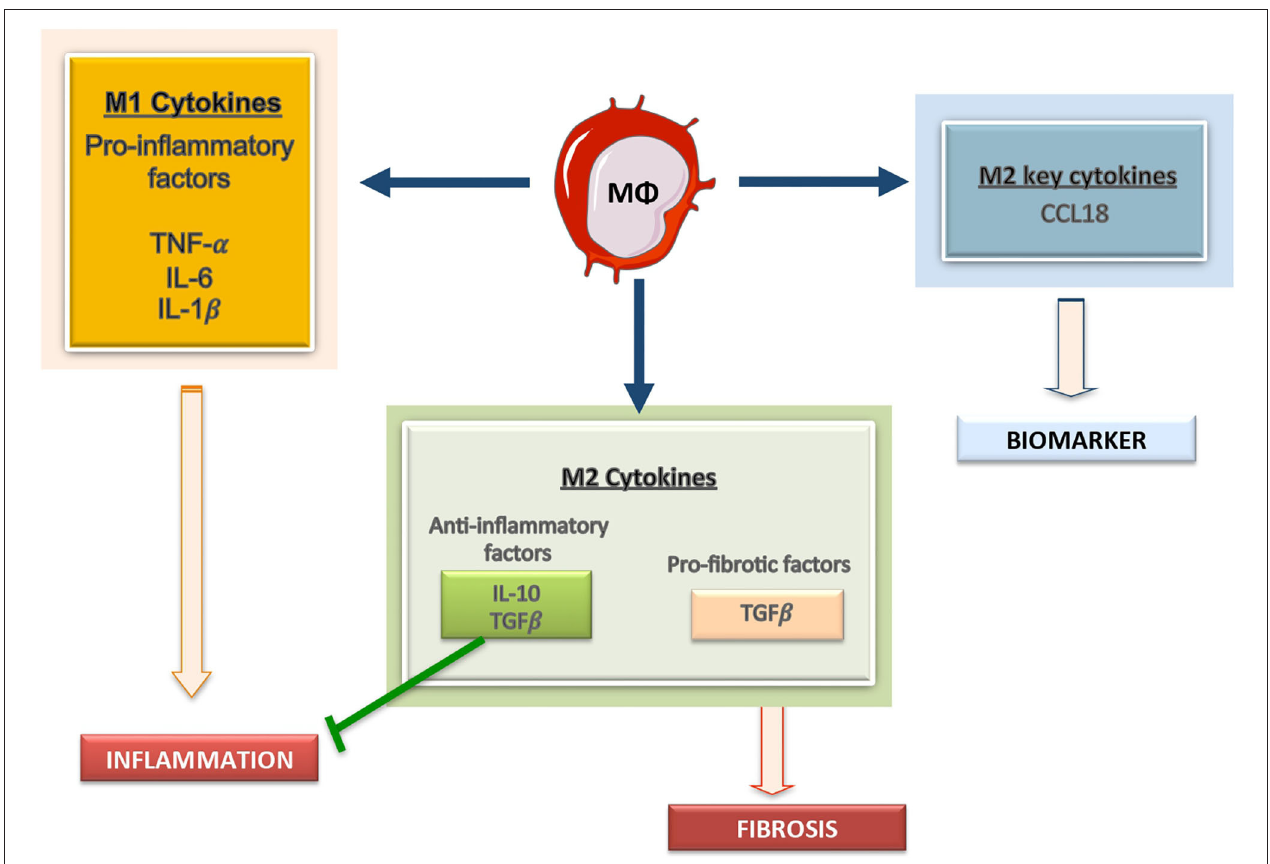
FIGURE 2 | Macrophages derived cytokines can contribute to kidney damage. Macrophages can secrete a large array of molecules, including producing pro-inflammatory mediators, including IL1, Il6, and TNF, anti-inflammatory cytokines, such as IL-10, and profibrotic factors, like TGF- β . Among the M2 macrophage related factors CCL18 is a recent described cytokine and a potential biomarker of disease